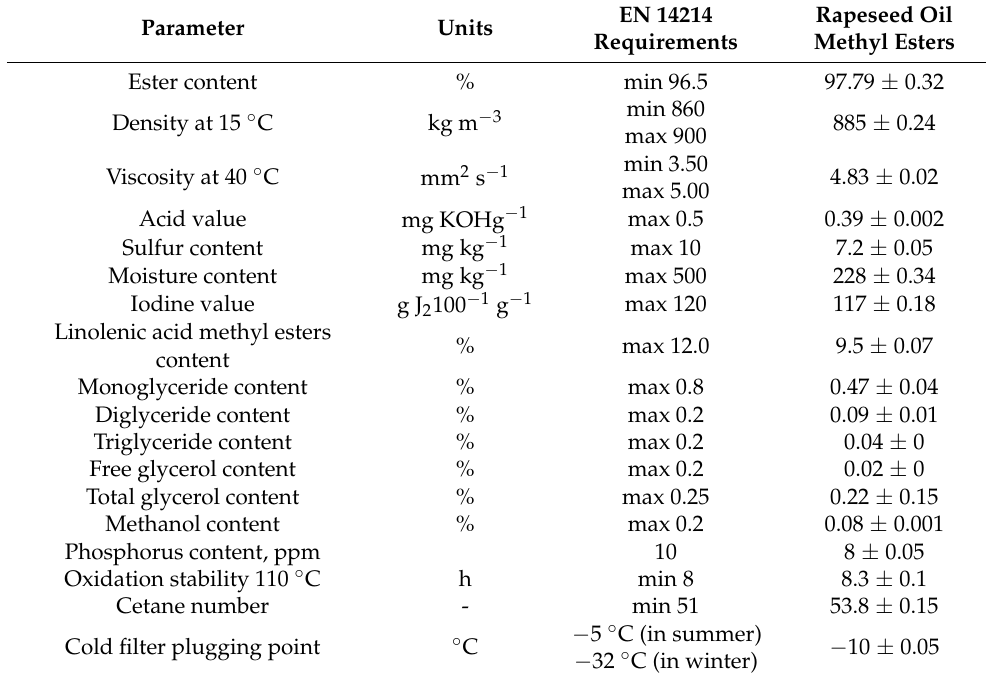
Table 6. The physical and chemical properties of rapeseed oil methyl